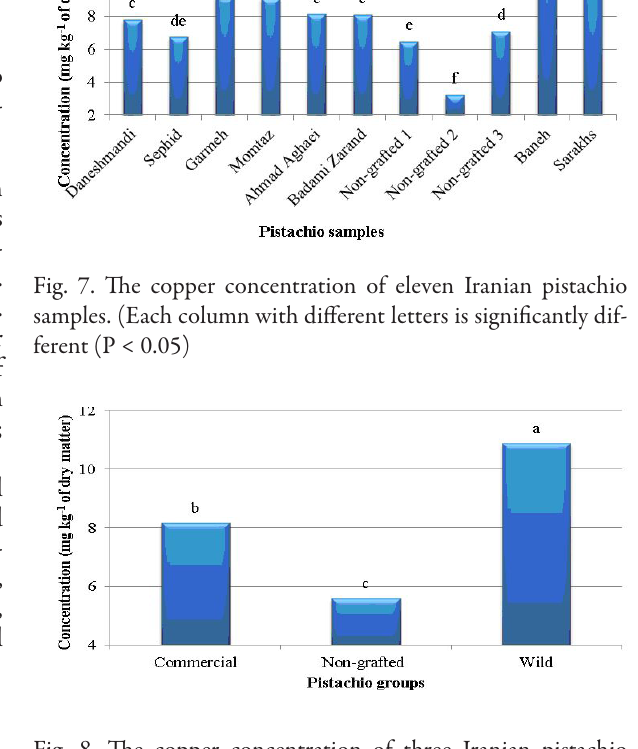
Fig. 8. The copper concentration of three Iranian pistachio groups. (Each column with different letters is significantly dif- ferent (P < 0.05)